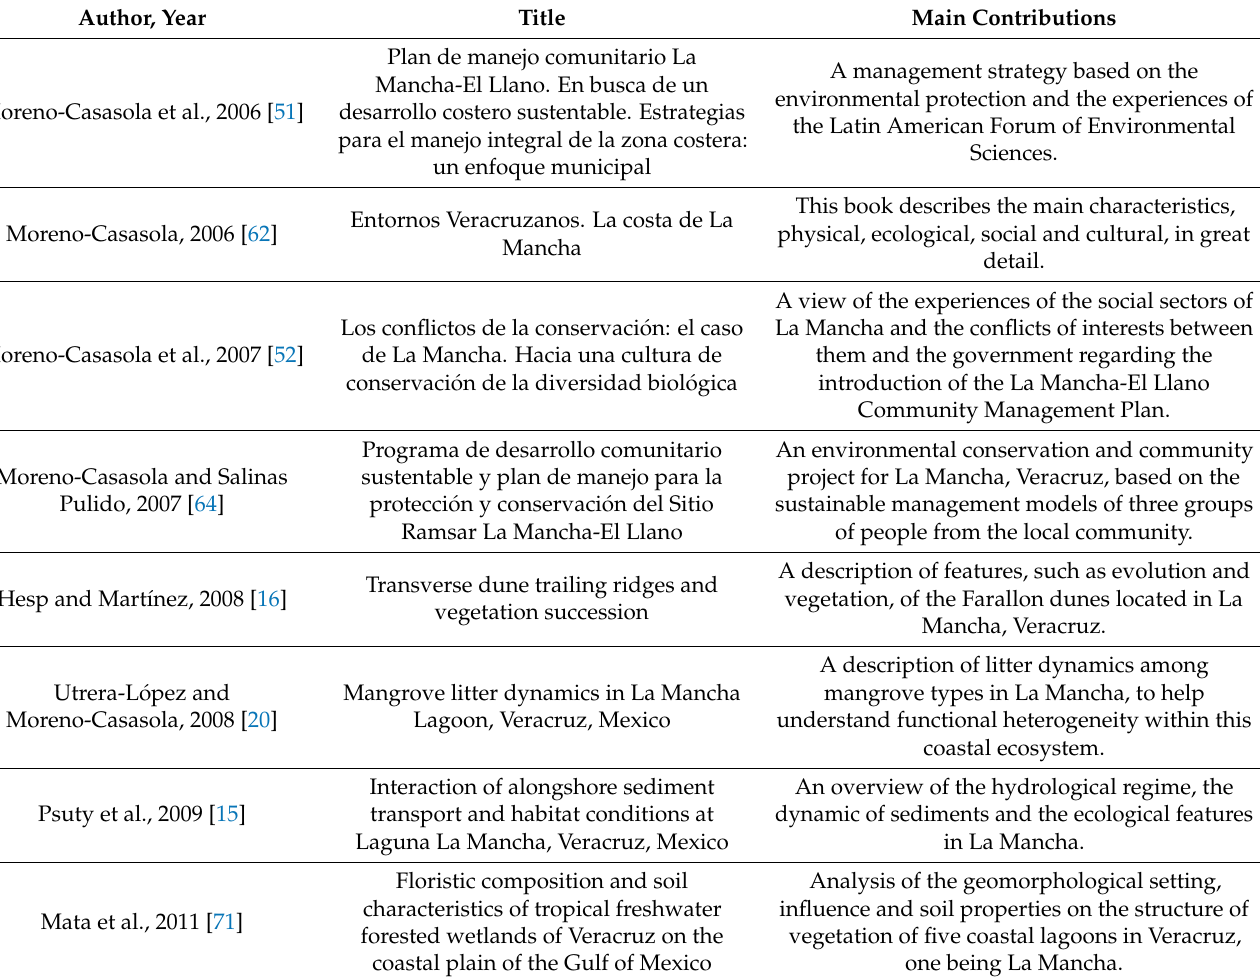
Table A1. List of relevant articles of La